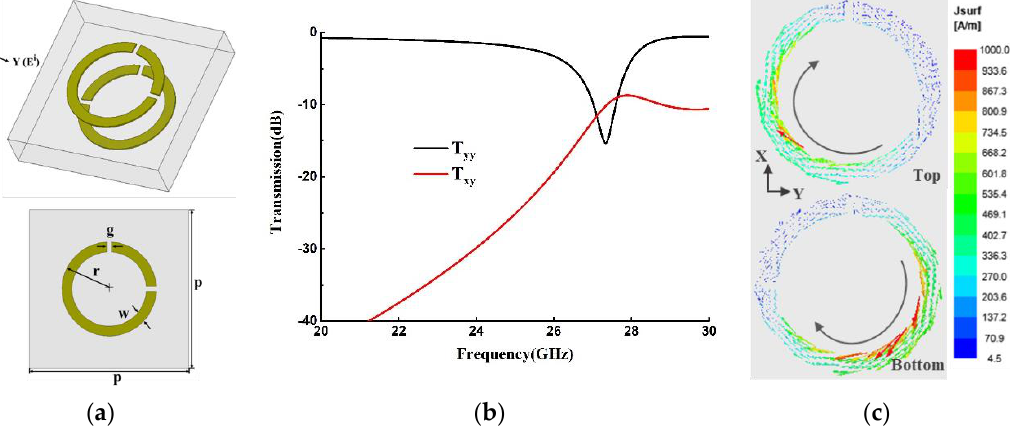
Figure 1. ( a ) Unit cell structure and its geometric parameters are as follows: p = 3.2 mm, r = 0.95 mm, w = 0.2 mm, and g = 0.1 mm. ( b ) Transmission coefficients of the transmitted wave with y-polarized incidence. ( c ) Surface current flow on the top and bottom layer of the meta-surface at 27.3 GHz.